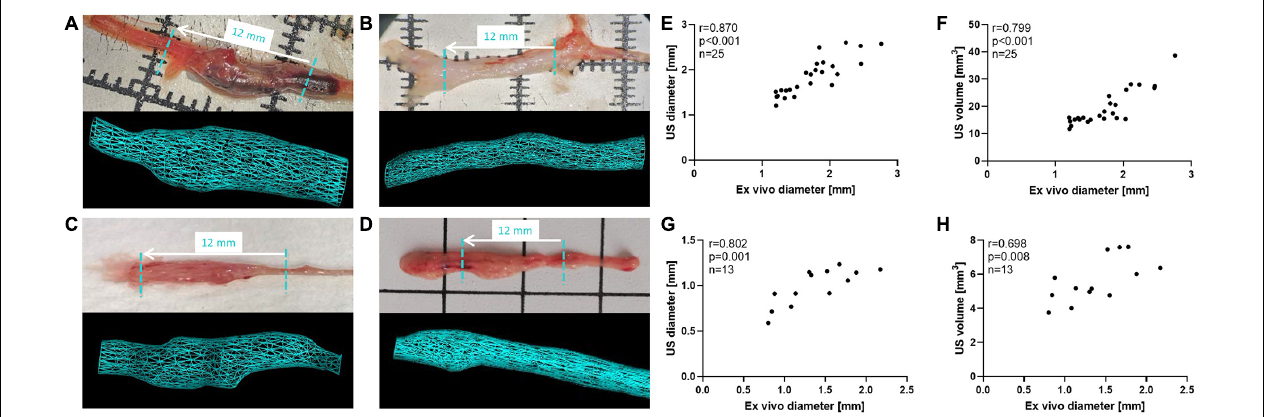
FIGURE 7 | Ex vivo measurements of maximum aortic diameter compared to ultrasound derived AAA parameters. (A–D) Excised aortas are shown in top panels, while 3D reconstructed aorta volumes are illustrated in bottom panels for the (A) AngII model, (B) ePPE model, (C) ePPE + BAPN model, (D) PPE model. The length of US screened aorta regions (12 mm) is indicated in the respective images of excised aortas by a dashed turquoise line. (E,G) The correlation between maximum aortic diameter as determined by 3D US or measured ex vivo in the (E) AngII model and (G) PPE model were evaluated by Spearman coefficient of correlation. The comparison between ex vivo AAA diameter and 3D US volume is shown in (F) for the AngII model and (H) for the PPE